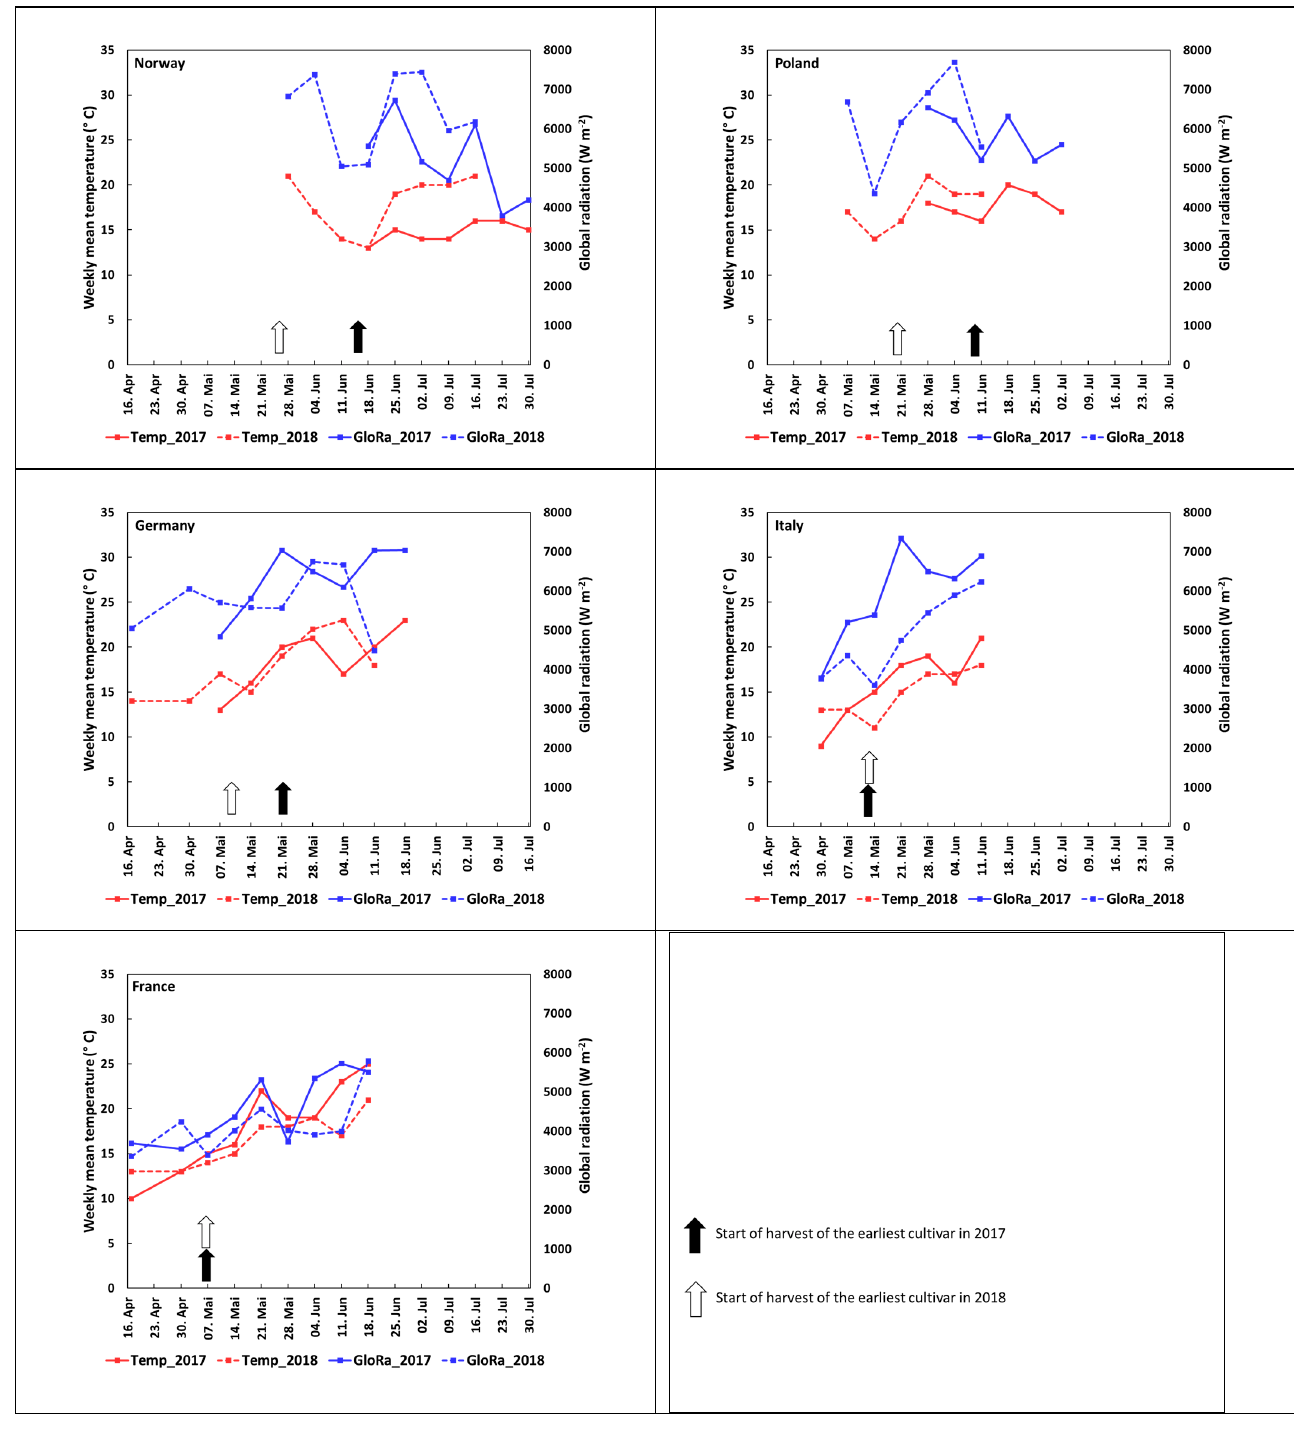
Figure 1. Weekly mean temperature and global radiation courses during the harvest season for the five experimental locations in 2017 and 2018, starting two weeks before the first picking of the earliest cultivar ‘Clery’.